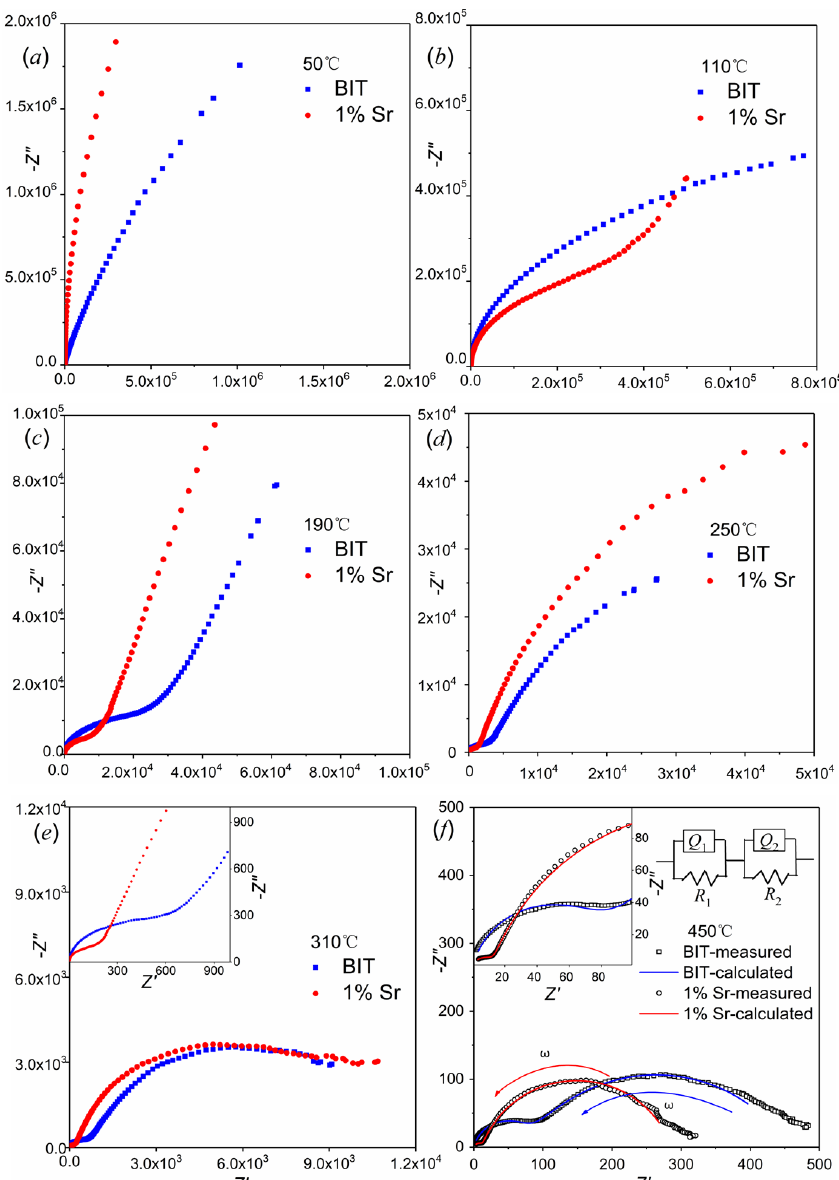
Fig. 4 Nyquist plots of complex impedance ( Z  vs. Z  ) of BIT and 1%Sr samples at several temperatures: (a) 50 ℃ , (b) 110 ℃ , (c) 190 ℃ , (d) 250 ℃ , (e) 310 ℃ , (f) 450 ℃